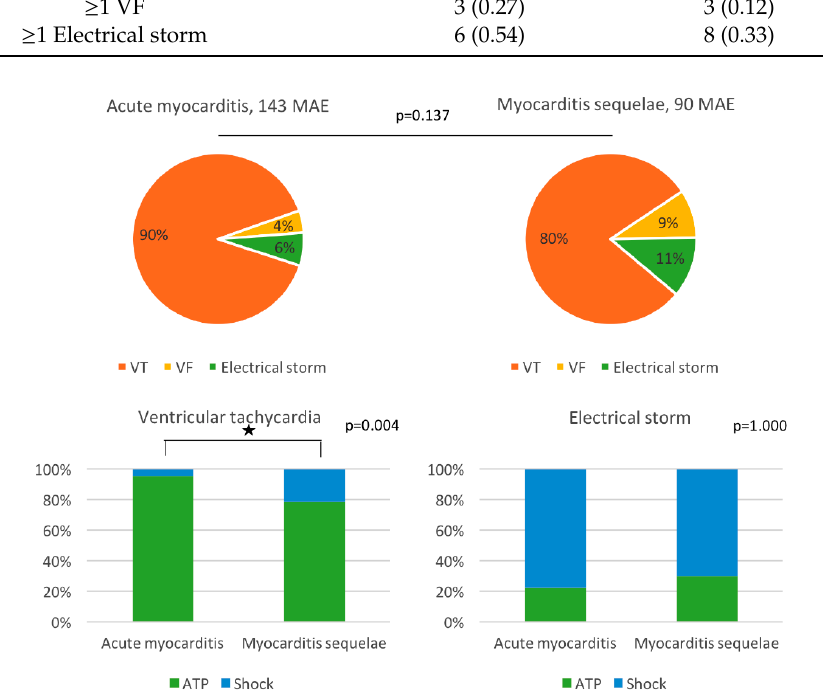
Figure 3. Distribution and treatment of major arrhythmic events (MAEs) in the two groups. VT: ventricular tachycardia, VF: ventricular fibrillation, ATP: antitachycardia